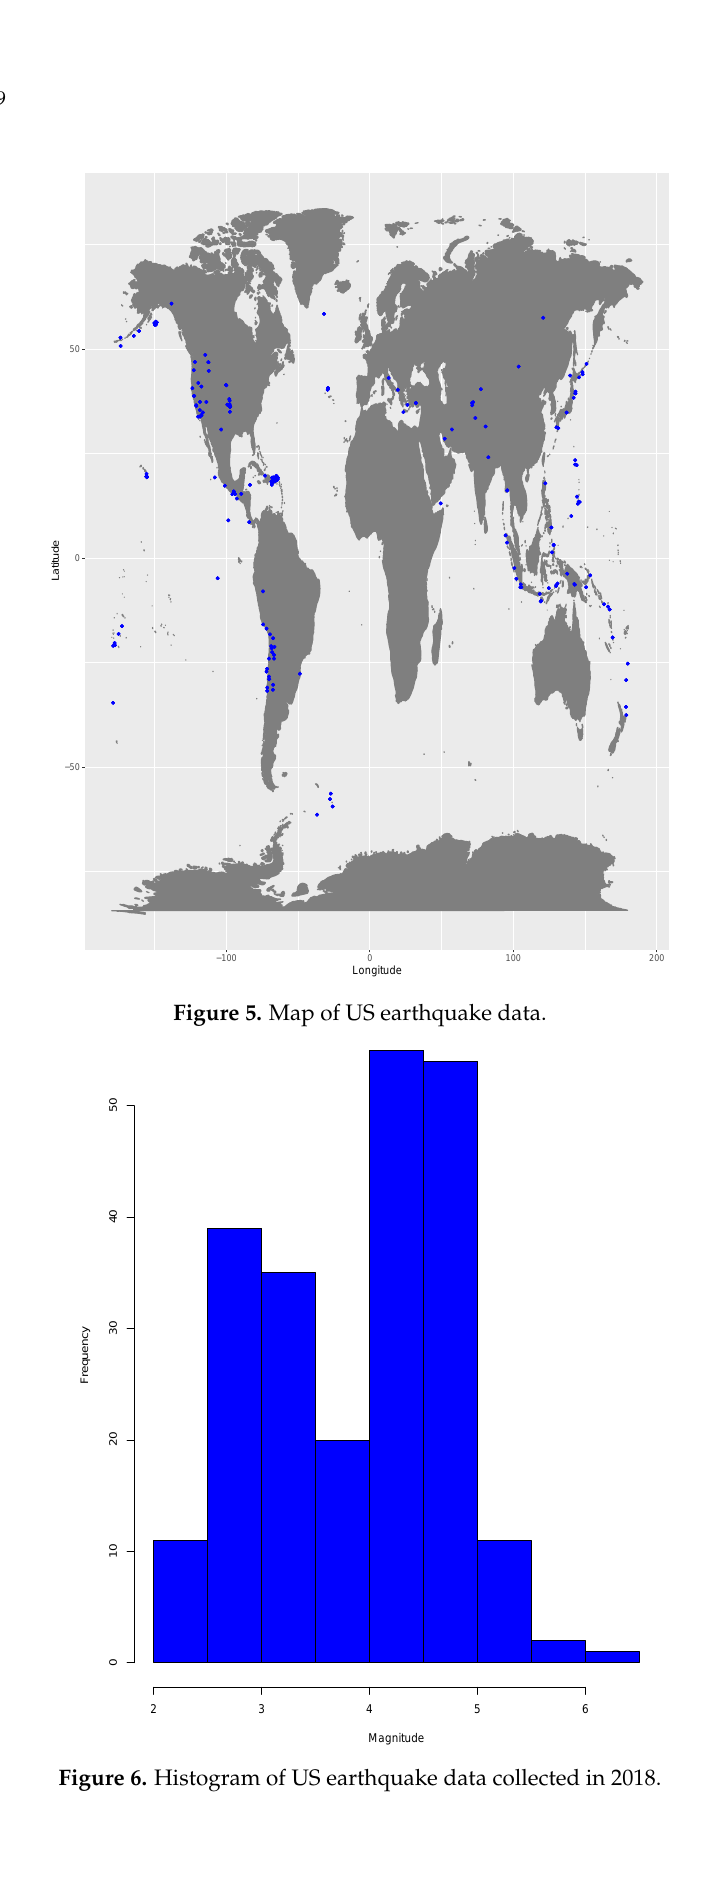
Figure 6. Histogram of US earthquake data collected in